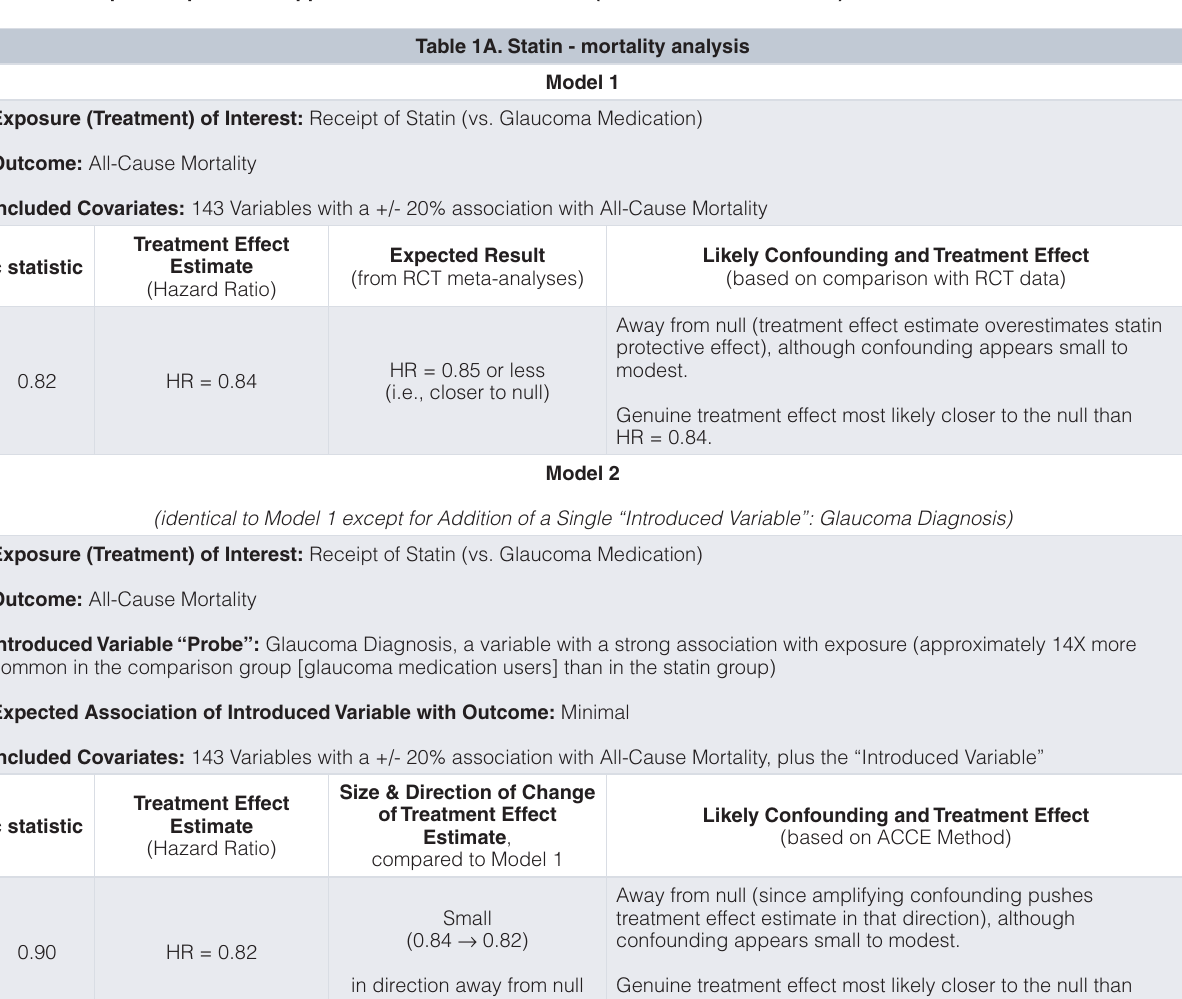
Table 1. Examples of qualitative application of the ACCE Method (drawn from Reference 10).